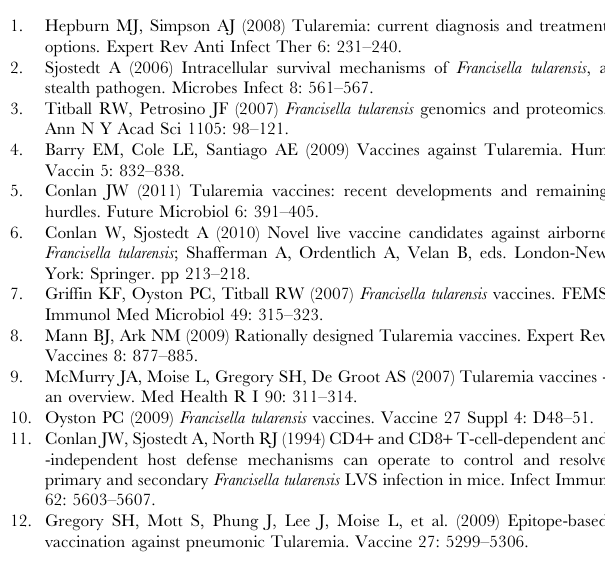
Table S1 List of 401 peptides selected from clusters of density 0.8 up to 1.0 (not including 1.0). The affinity provided is the IC 50 value predicted for a particular responder sequence by the NetMHC3.0 program. The gi number and annotation of the source protein are according to the F. tularensis holarctica LVS sequence deposited at the NCBI (GenBank accession AM233362);